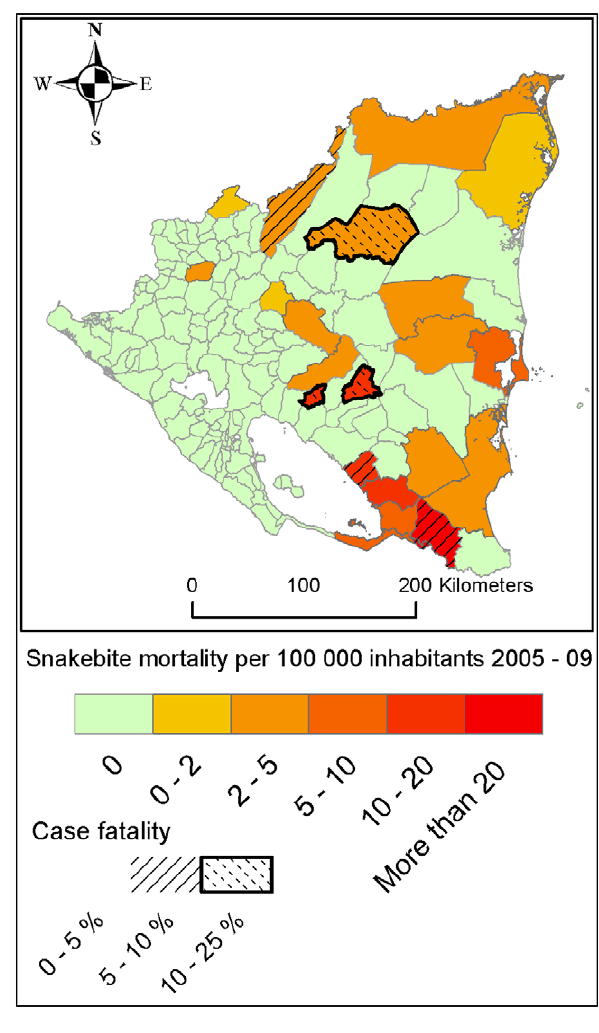
Figure 4. Snakebite mortality 2005–2009 according to data reported from the Nicaraguan Ministry of Health (MINSA).